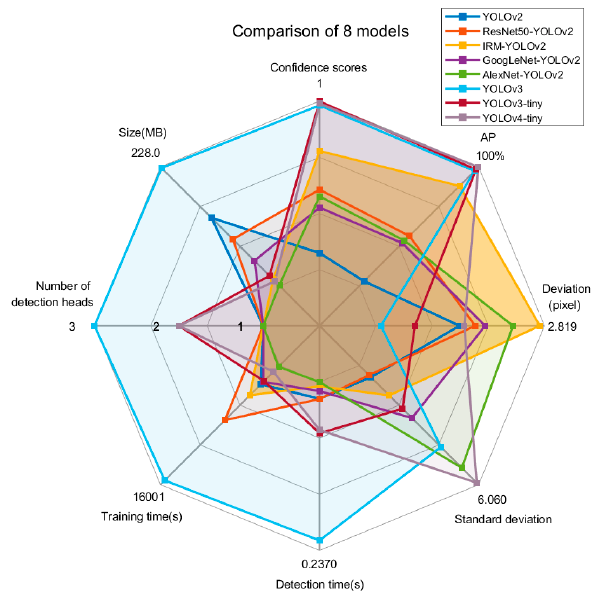
Figure 11. Detection performance of different algorithms.